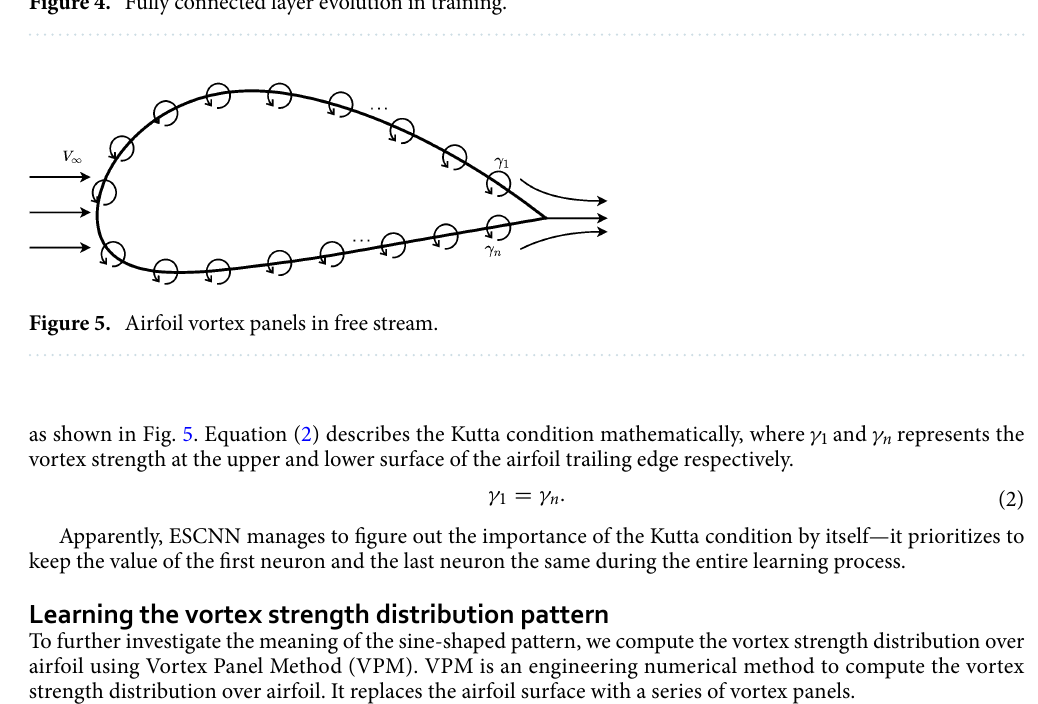
Figure 4. Fully connected layer evolution in training.